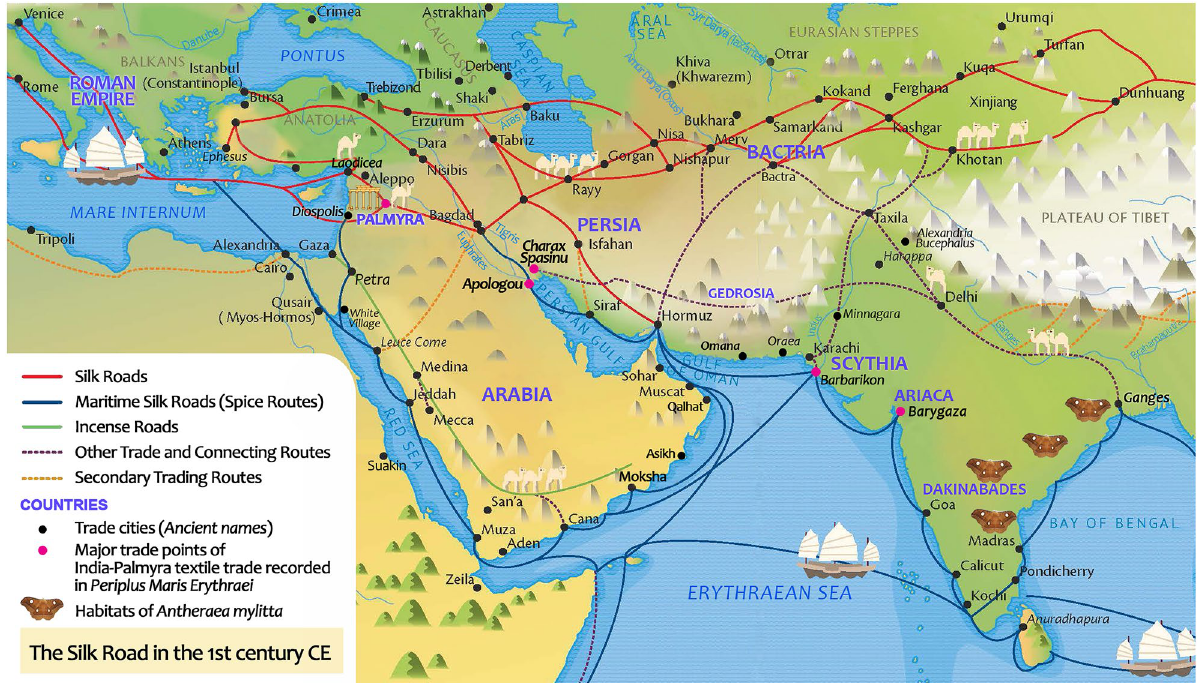
Figure 6. A representation of the Silk Road in the first century CE (adapted from the Silk Road Interactive Map, http:// unesc osilk road8. dev2. agile drop. com/ silkr oad- inter active- map) and the suggested textile trade routes from India to Palmyra. In Periplus Maris Erythraei , silk and cotton were exported to Palmyra from the ports of Barygaza and Barbarikon 43,60,61